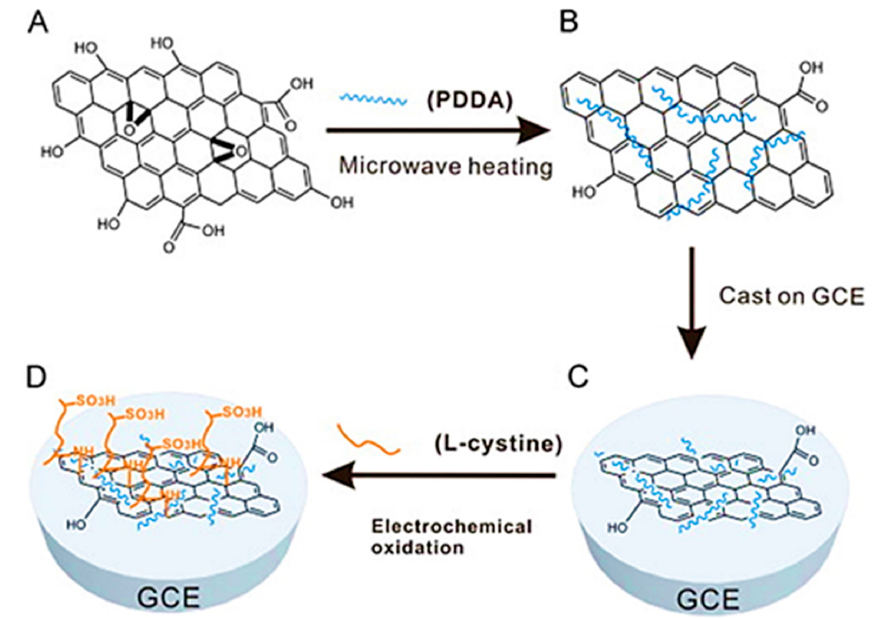
Figure 1. Layout of graphene functionalization and development of L-cystine / PDDA-graphene / GCE electrochemical sensor-( A ) exfoliated graphene oxide, ( B ) poly(diallydimethylammonium chloride)-functionalized graphene obtained by a microwave-heating procedure, ( C ) functionalized graphene modified GCE, and ( D ) immobilization of L-cystine on functionalized graphene modified GCE by electrochemical grafting (reproduced from [75], with permission from Elsevier, 2012).